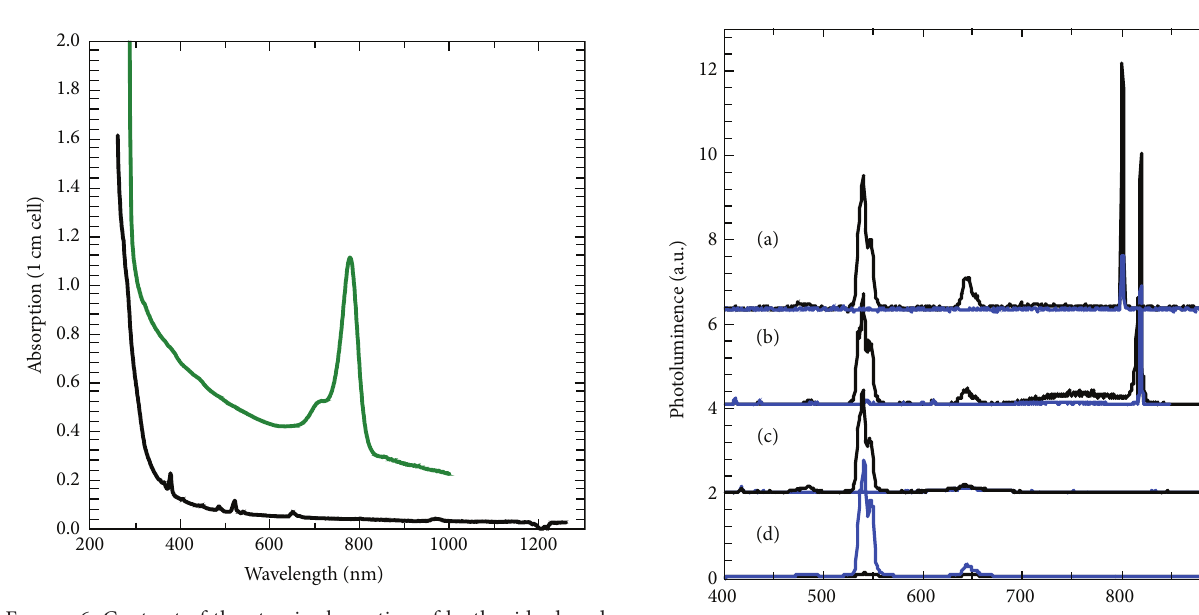
Figure 6: Contrast of the atomic absorption of lanthanide-doped nanoparticles with the molecular absorption of the dye-attached nanocomposite. The black curve is the optical absorption of a colloidal solution of NaY 0.85 Er 0.15 F 4 (37 mg/mL in hexane), while the green curve is the optical absorption of 17 mg/mL solution of the nanoparticles after functionalization and reaction with DyL800 infrared dye.